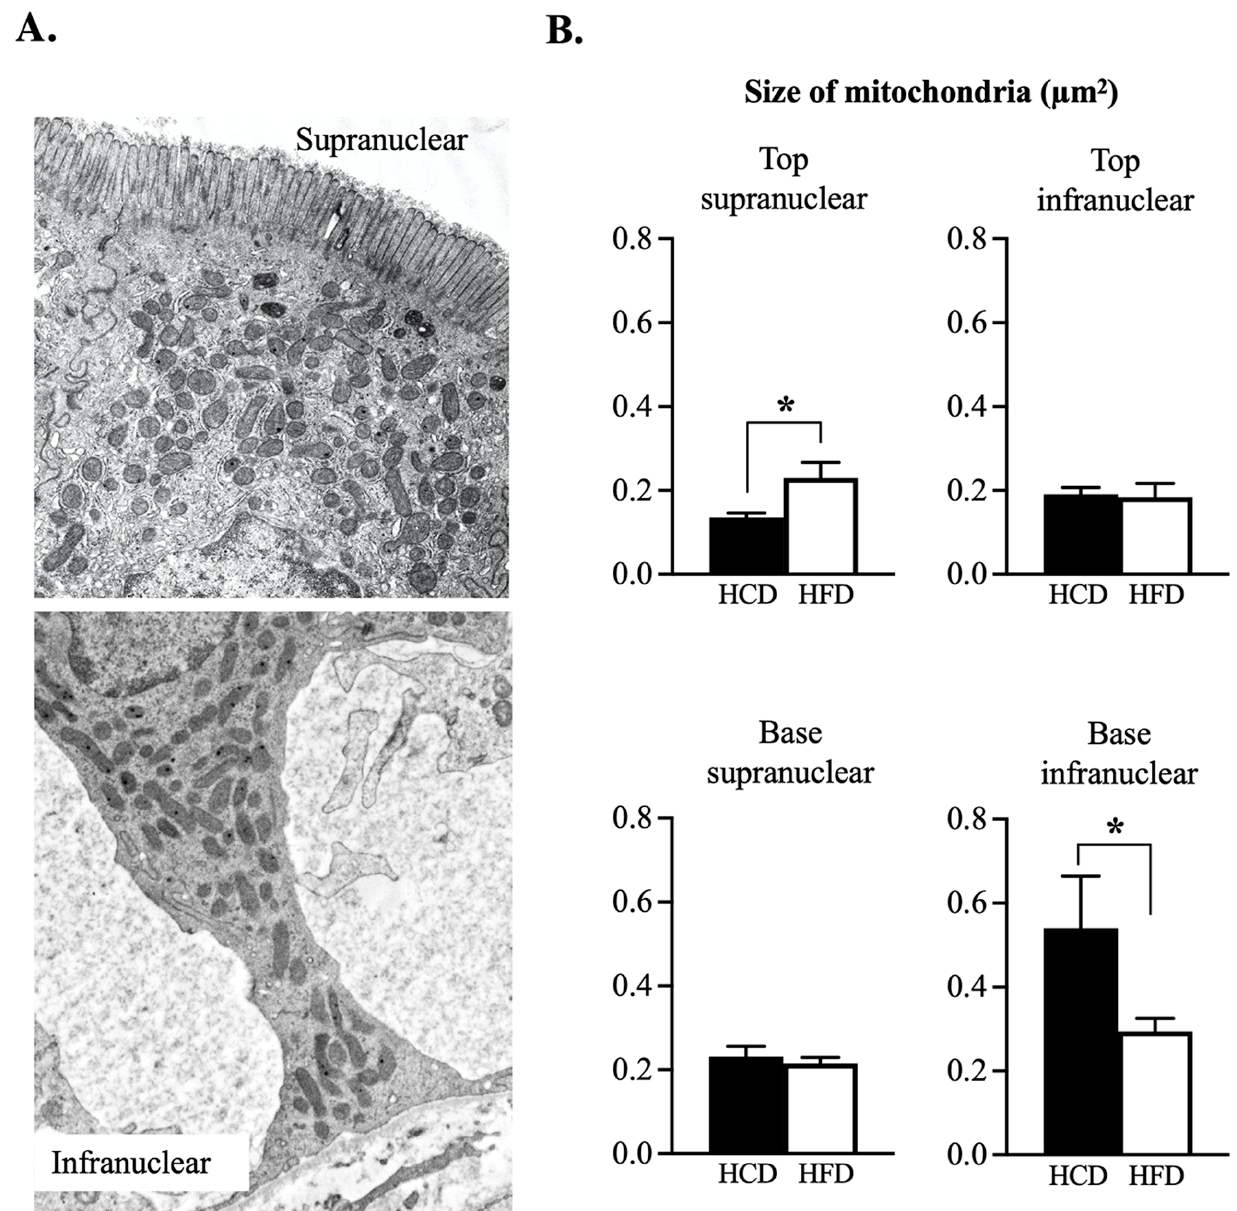
Figure 4. ( A ). The figure shows examples of mitochondria in the supranuclear and infranuclear parts where most mitochondria appeared to be spherical or slightly oval in shape. ( B ). The size of mitochondria showing that the top supranuclear had increased following HFD ( p = 0.02) compared to HCD. The opposite was the case at the base, infranuclear part, where the size increased with HCD ( p = 0.02) compared to HFD. No differences were noted in the top region infranuclear part, as well in the base region supranuclear parts of the enterocyte. Electron microscopy: ×8000, n = 6 pairwise comparisons, * p ≤ 0.05 Wilcoxon signed-rank test.